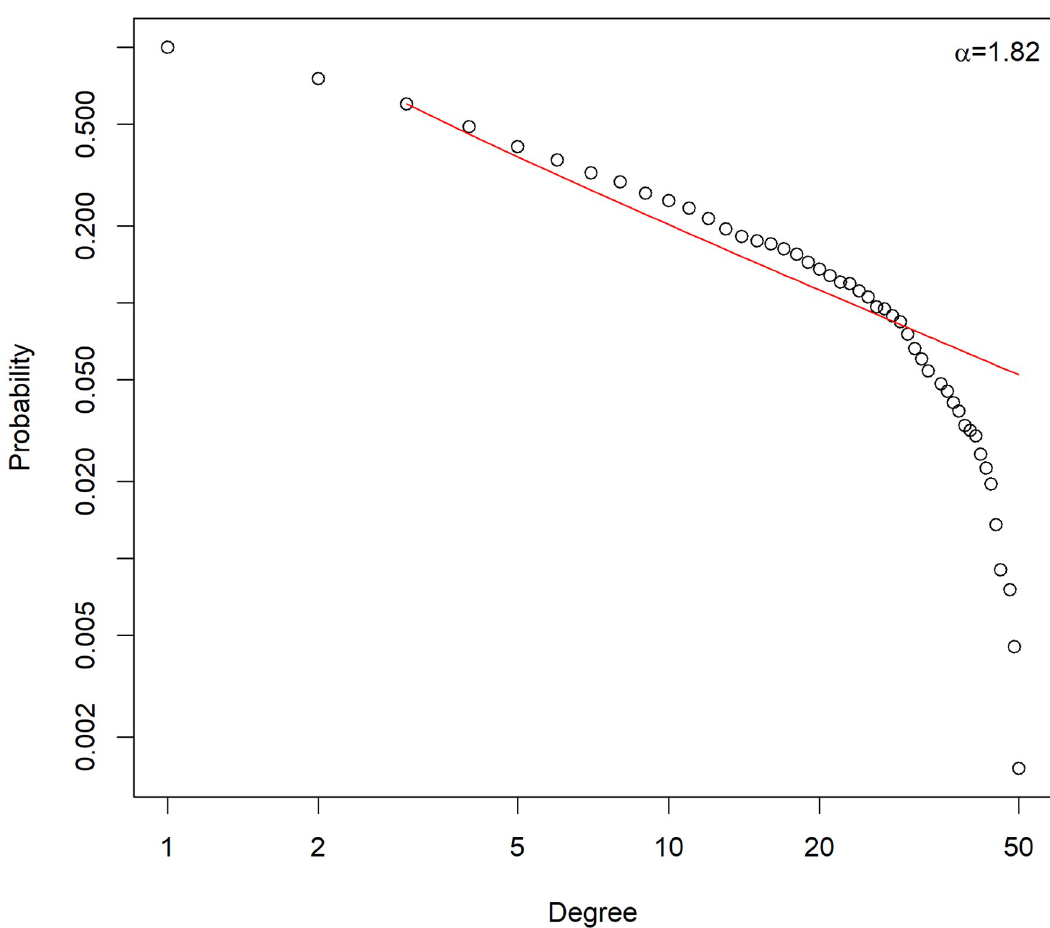
Fig 2. Degree distribution of the mitochondrial PPI network (nodes: 665, edges: 2708), following a power law. The circles represent the fraction of nodes with a given degree and the solid line indicates the power-law fit to the data.